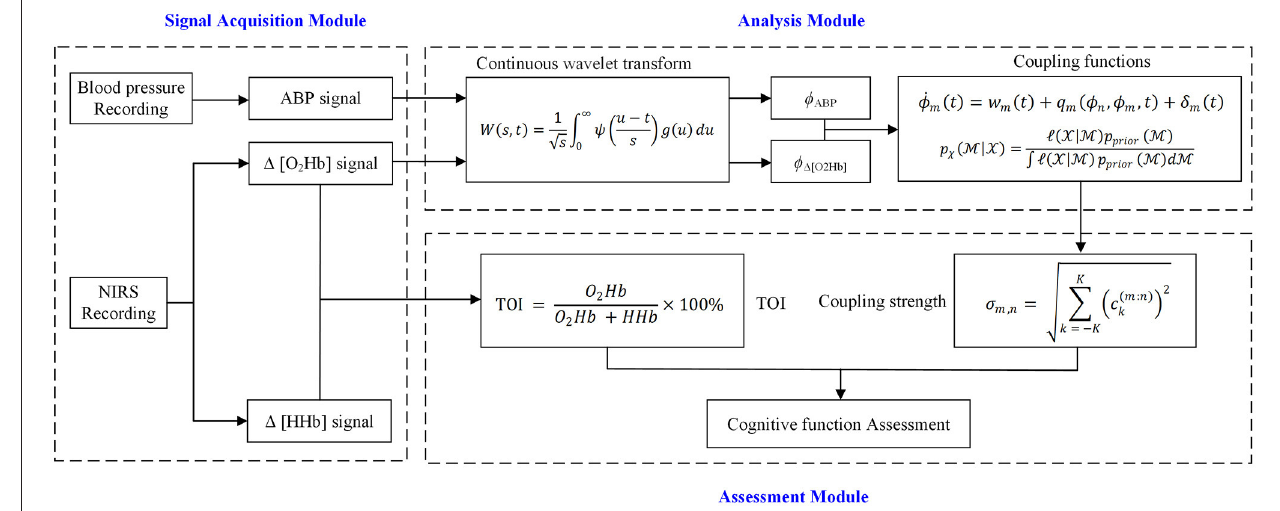
FIGURE 2 | Overview of modeling of interaction between NIRS and ABP